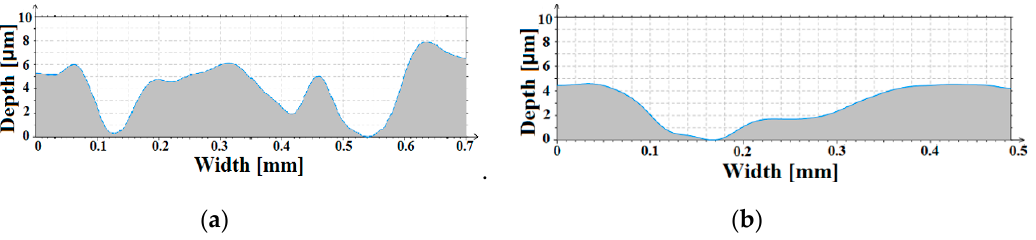
Figure 9. Profiles of wear paths; steel equivalent 42CrMo4 (i.e., CSN 41 5142); performed by Talysurf CLI 1000. ( a ) Profile of wear path of non-nitrided specimen; vz. 51; R = 26 mm; 500 rpm; 18 min; F = 20 N; T = 80 °C — on left. ( b ) Profile of wear path of nitrided specimen; vz. 1-2; R = 26 mm; 500 rpm; 18 min; F = 20 N; T = 80 °C — on right.